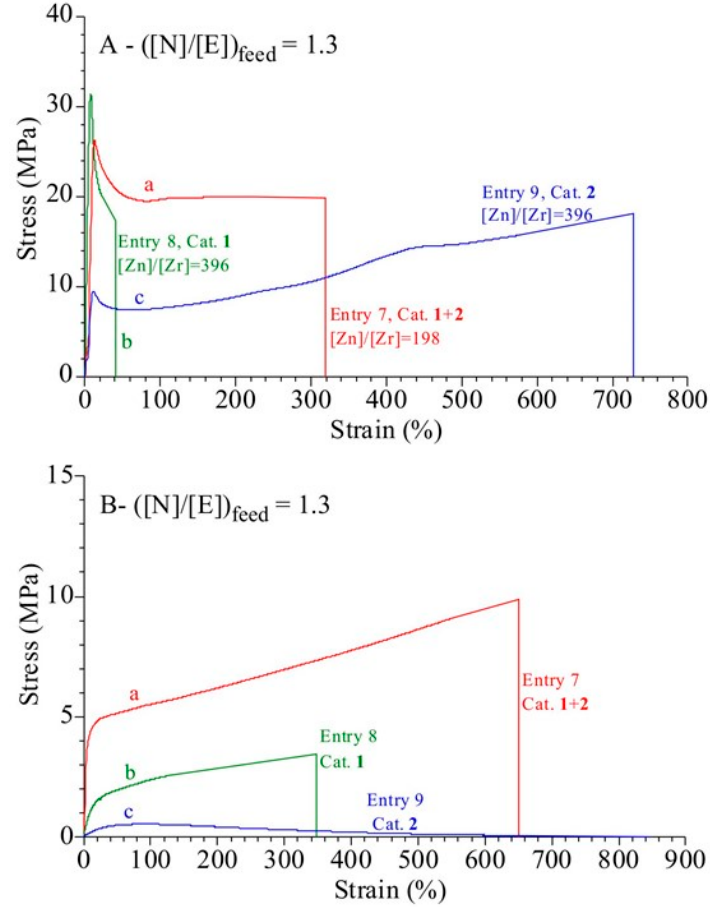
Figure 8. Stress–strain curves of compression molded films of poly(ethylene- co -norbornene) copolymers synthesized with the catalysts 1 , 2 and 1 + 2 , at [N]/[E] feed ratio of 1.3 and at the highest [Zn]/[Zr] ratio (entries 7, 8 and 9), stretched at: 25 °C ( A ); and 50 °C ( B ). All samples were stretched at rate v = 10 l 0 with l 0 the initial gauge length.